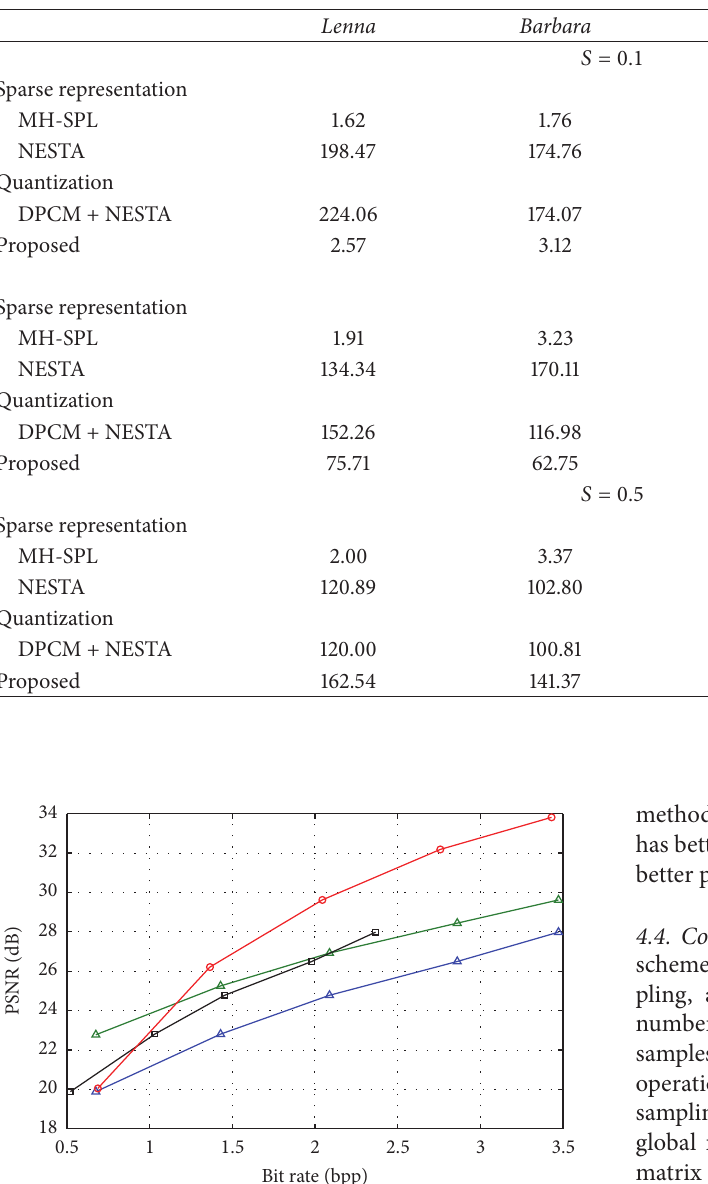
Table 2: Comparison of execution time(s) to reconstruct an image when using different algorithms.